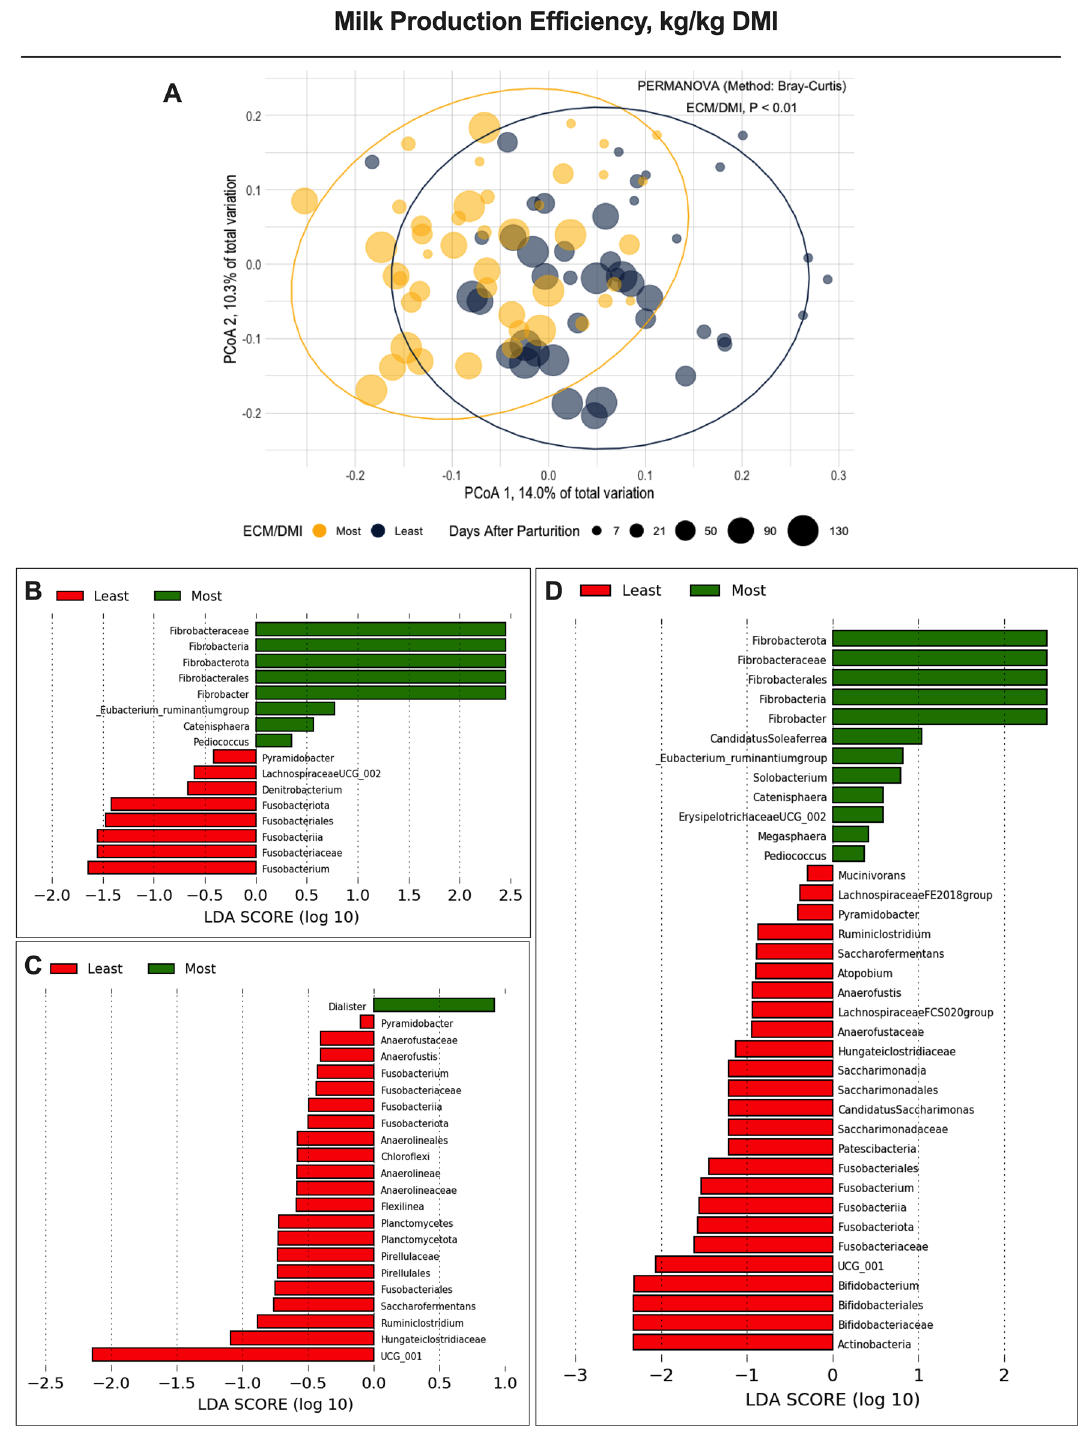
Figure 5. Beta-diversity analyses from the lower gut microbiome of first lactation Holstein cows differing in production efficiency (kg/kg DMI). ( A ) Principal Coordinate Analysis (PCoA) and permutational multivariate analysis of variance (PERMANOVA) in the cows grouped by milk production efficiency; Significance was declared at P ≤ 0.05. ( B – D ) Linear discriminant analysis of effect size (LEfSe) using Kruskal–Wallis, Wilcoxon, and linear discriminant analyses to detect microorganisms associated with production efficiency variables [( B ) efficiency of producing energy-corrected milk, ECM; ( C ) efficiency of producing milk fat, MFE; and ( D ) efficiency of producing milk protein, MPE]. Amplicon sequence variants significant in all three tests display a LDA score > 2.0 and the remaining ASVs were significant in at least two other